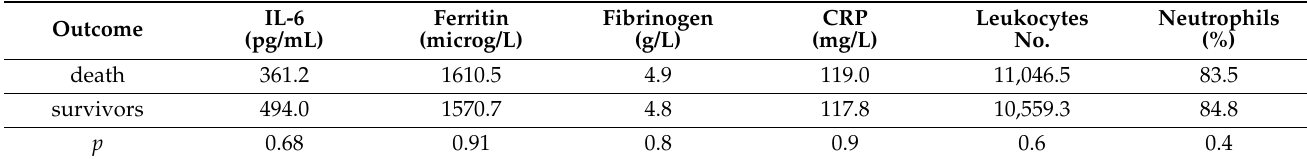
Table 4. Mean levels of some inflammatory markers according to the patient’s